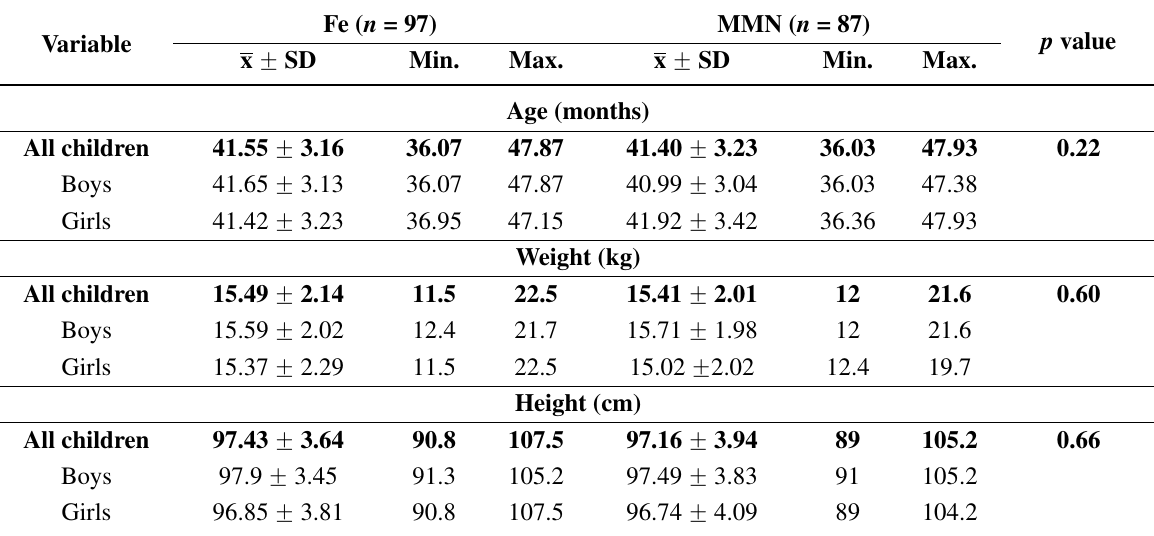
Table 1. Characteristics of the study population.